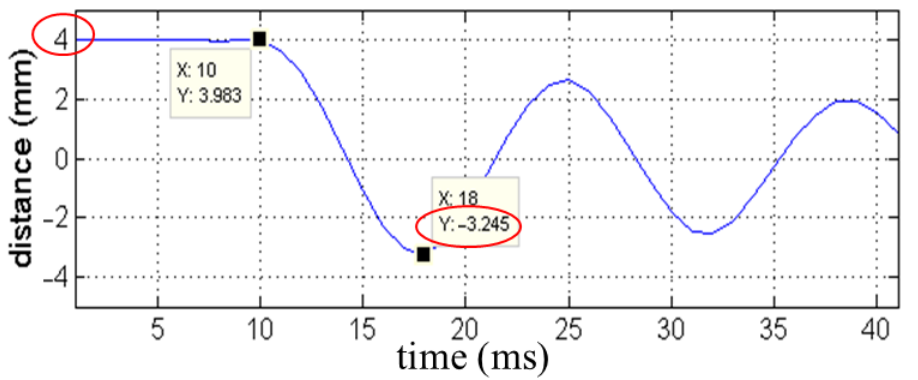
Figure 5. Hybrid EM valve release test data.